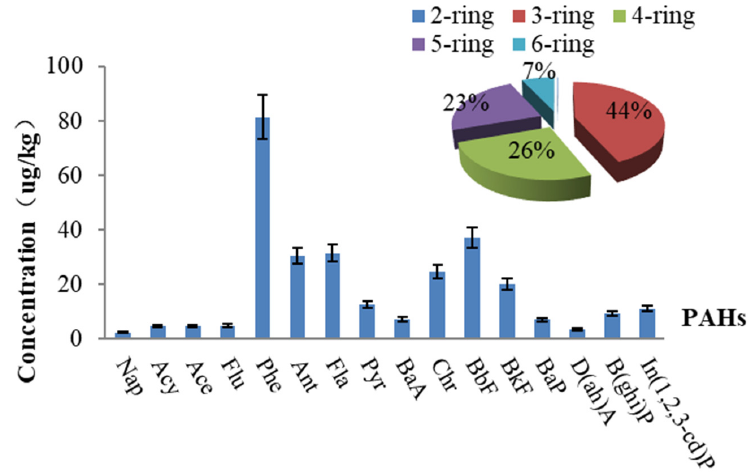
Figure 3. Proportion of different components of PAHs in the soils and sediments in the Poyang Lake District.